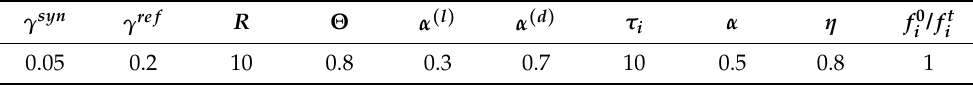
Table 3. The parameters of backward transmission.